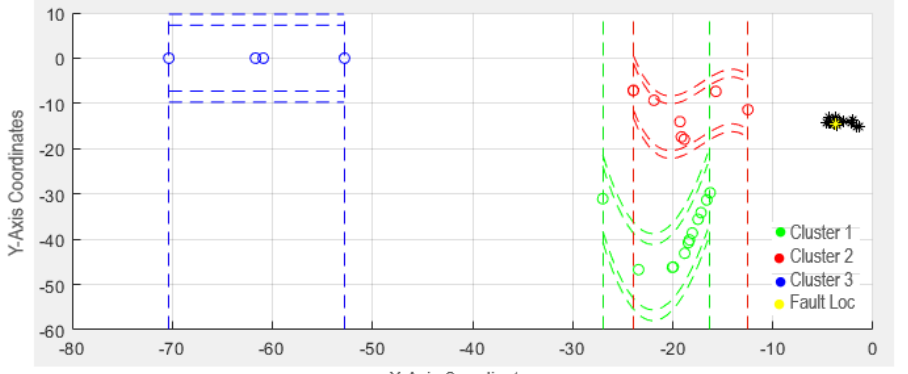
Figure 16. 100 Ω fault identified.